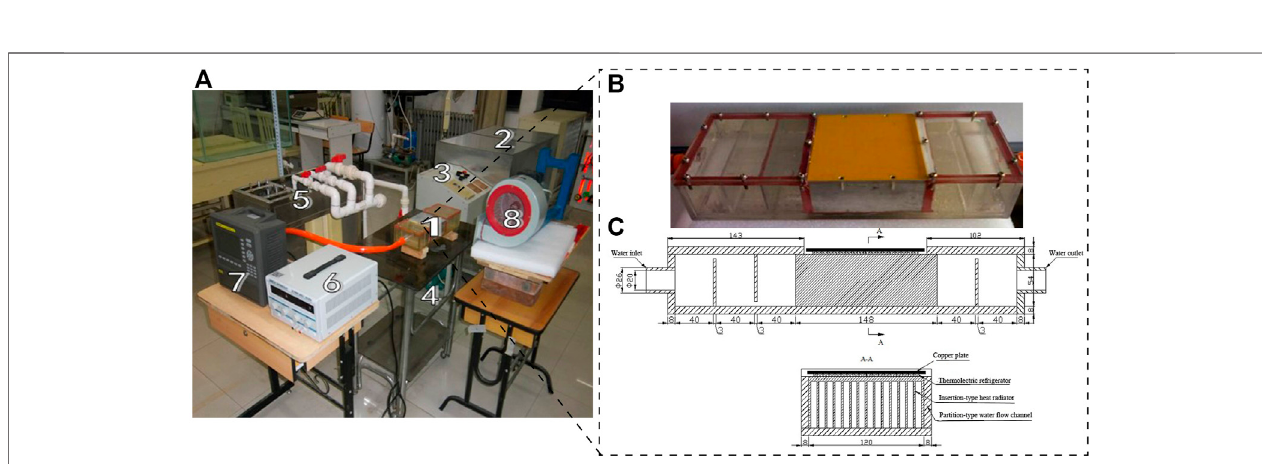
FIGURE 2 | Experimental system for performance research. (A) Experimental system platform, 1-thermoelectric refrigeration membrane distillation cold chamber, 2-water storage tank, 3-distribution box, 4-magnetic force driving circulating pump, 5-LZB type glass rotameter, 6-voltage, and current stabilization power supply, 7- TP700 multi-channel data logger, 8-fan. (B, C) schematic of the membrane distillation cold chamber with thermoelectric refrigeration.